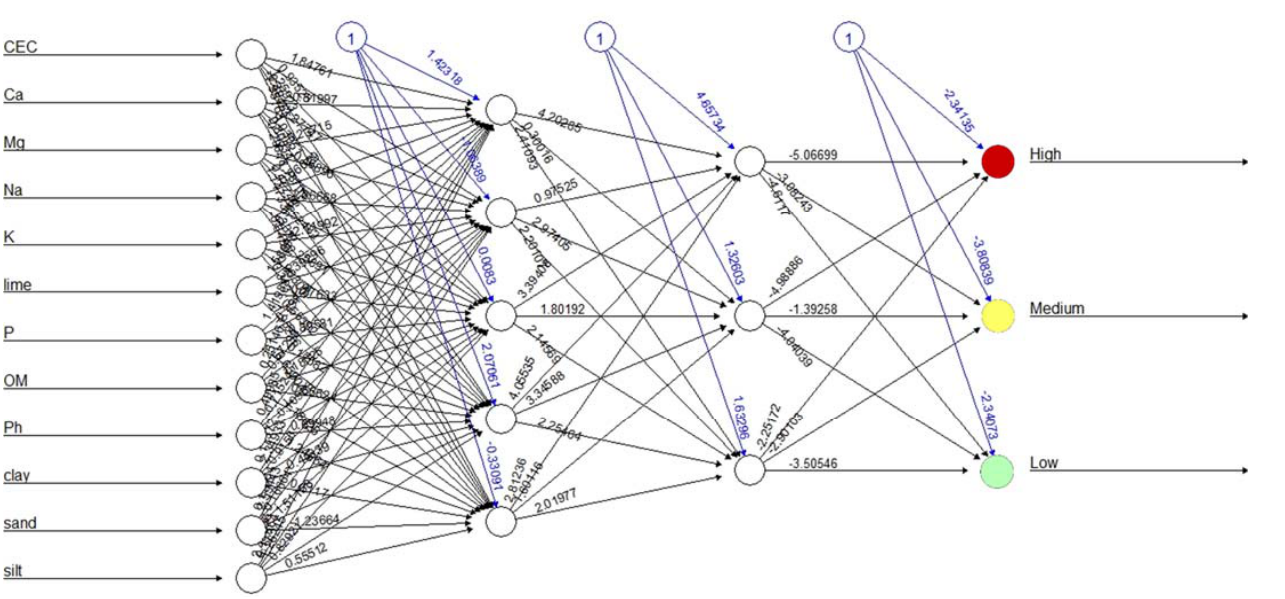
Figure 5. Pruned structure of the multilayer perceptron artificial neural network for predicting Verticillium dahliae inoculum density (ID) classes (low, medium, and high) in a study where the effect of cropping systems was assessed on the ID of V. dahliae in olive-growing areas of the Iberian Peninsula based on CEC (meq 100g − 1 ), Ca (meq 100g − 1 ), Mg (meq 100g − 1 ), Na (meq 100g − 1 ), K (meq 100g − 1 ), P (meq 100g − 1 ), lime (%), OM (%), pH, and percentage of clay, sand, and silt parameters. The neural net was trained by resilient backpropagation with weight backtracking [32] reaching two hidden layers of 5 × 3 neurons as optimal. The numbers between neurons represents these weights. Data include a training set (75%) from a dataset (84 samples) comprising all experimental combinations of four previous cropping history groups (VWO—barely favourable, favourable, very favourable, and extremely